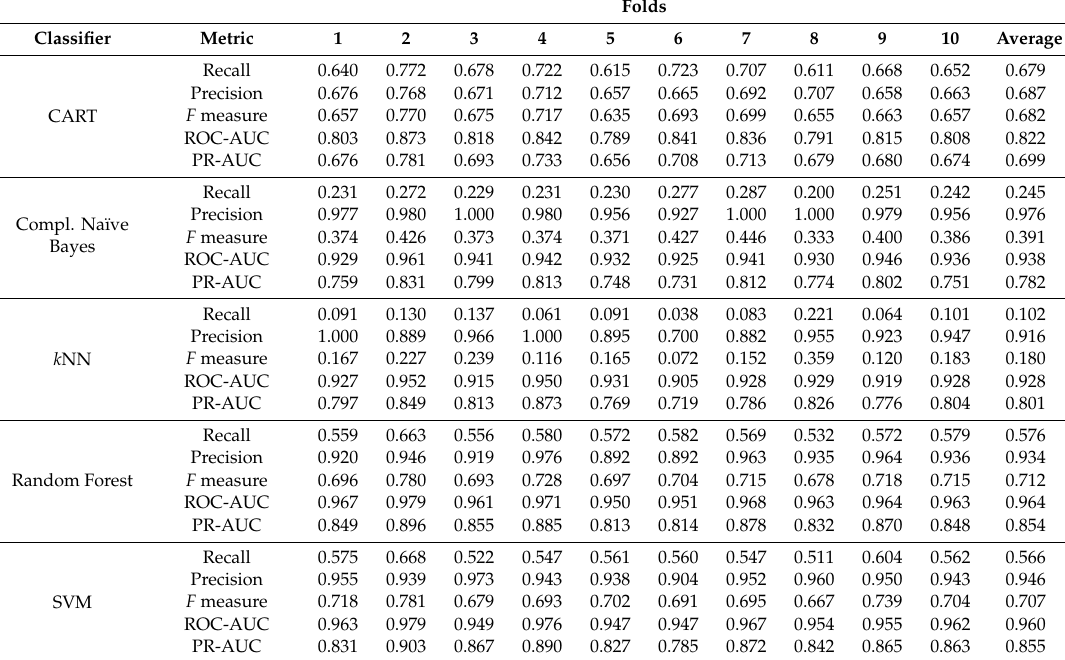
Table 2. Metrics calculated through 10-fold cross-validation for the five classifiers.